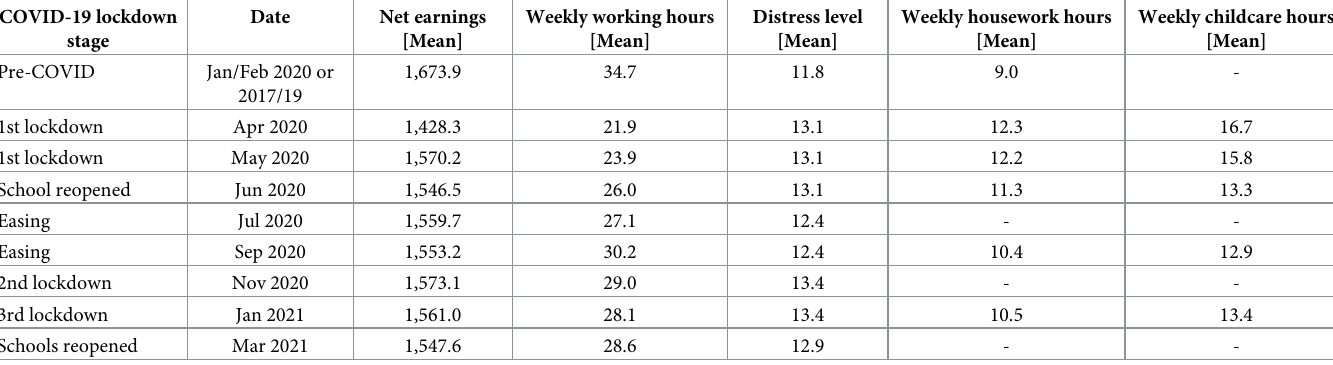
Note: Cross-sectional baseline respondent weight was applied to represent the population of all adults (16+) who were resident in private households in the UK at the time of wave 9 (2017/18), and who did not die or emigrate before the relevant web survey. Data source: UKHLS main survey waves 1 to 10 (up to 2019) and COVID study waves 1 to